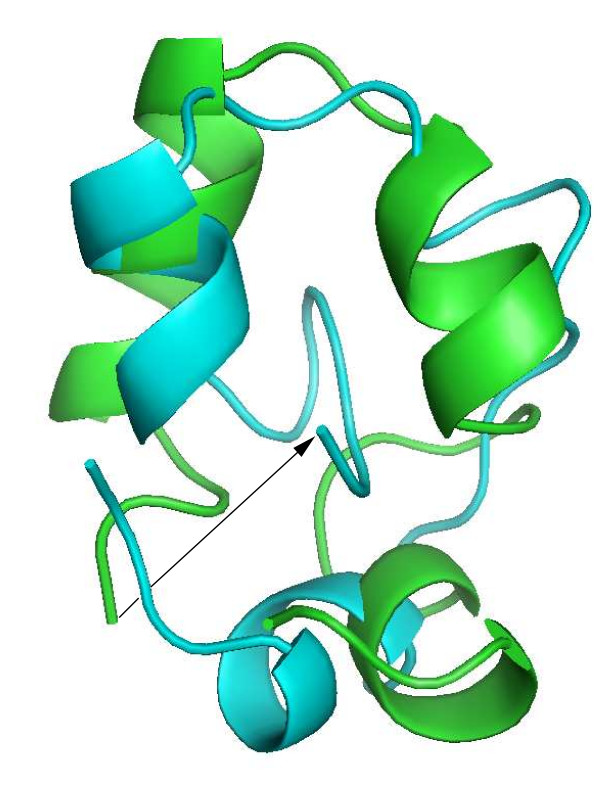
Superposition of representatives from the two stable sub-folds. Superposition of native VH (green) and sixfold mutant r1g11i0 (cyan). The two structures have been superimposed optimally with respect to their Cα positions (RMSD 5.9 Å) using the Kabsch-algorithm [44]. The arrow marks the shift of the C-terminus.